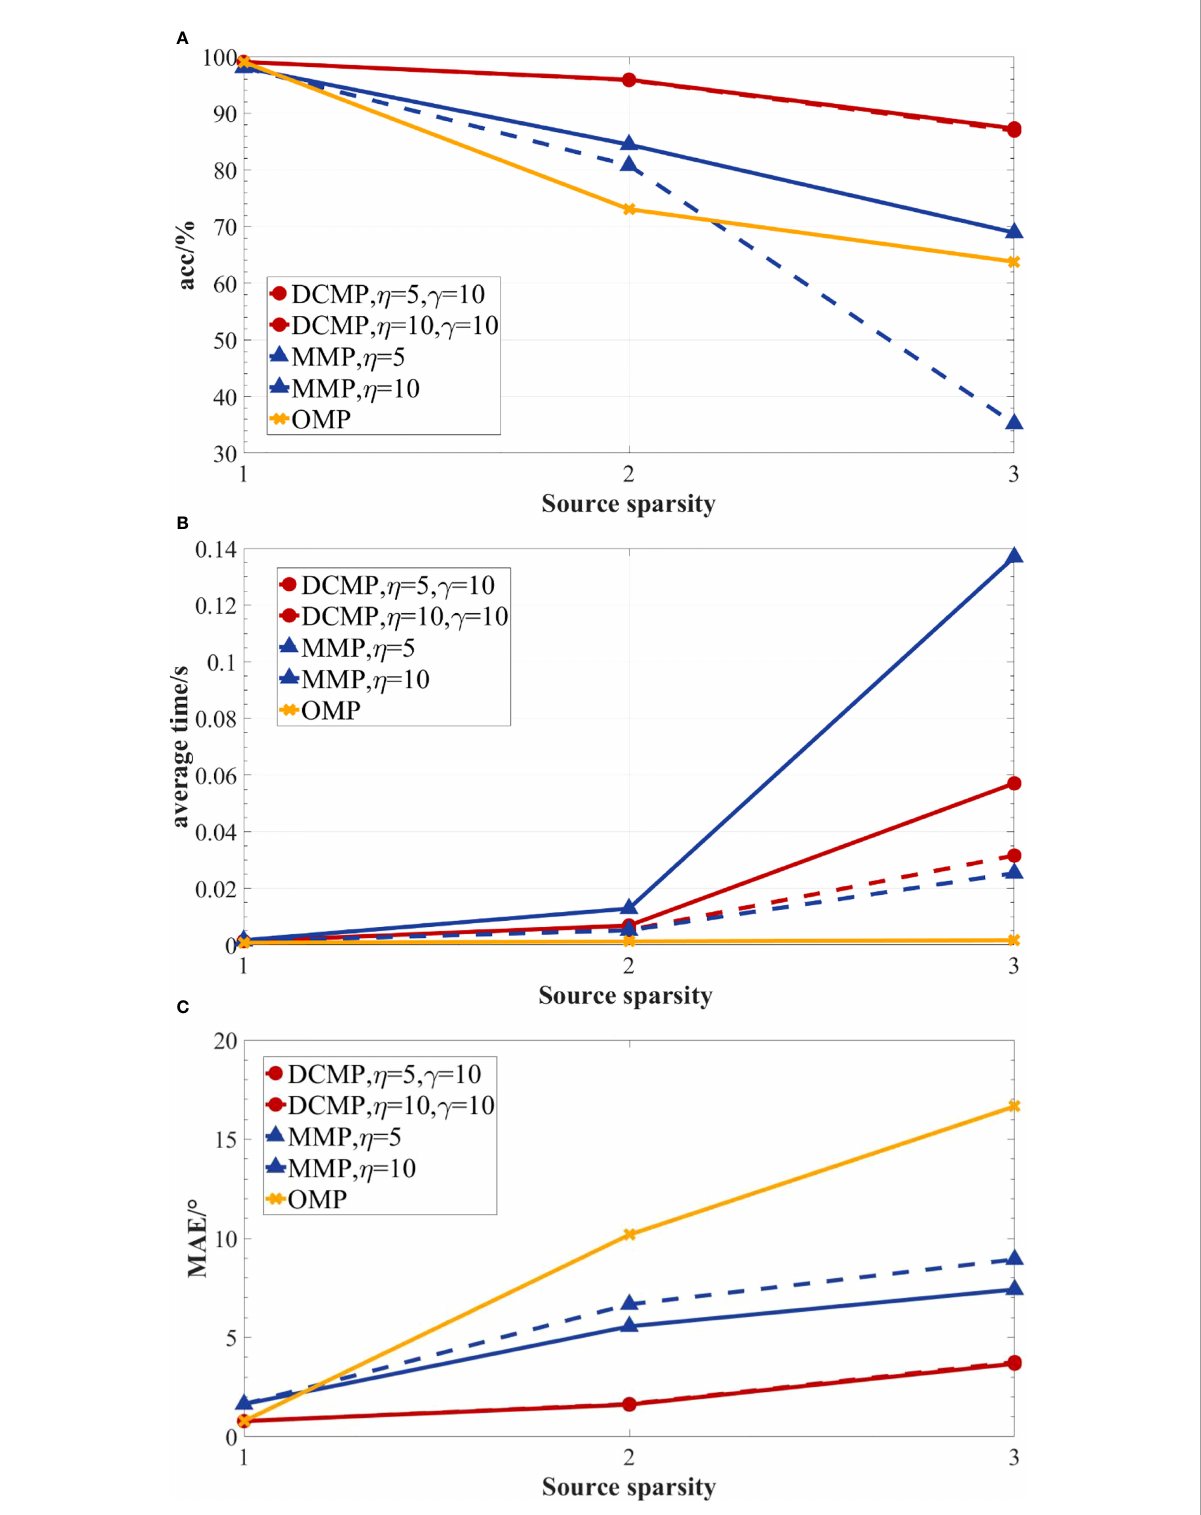
FIGURE 6 The performances of the DCMP, MMP, and OMP algorithms for different source sparsity under the SNR of 20 dB, a 12-element array, and 96 snapshots. (A) DOA prediction accuracy; (B) average estimation time; (C)